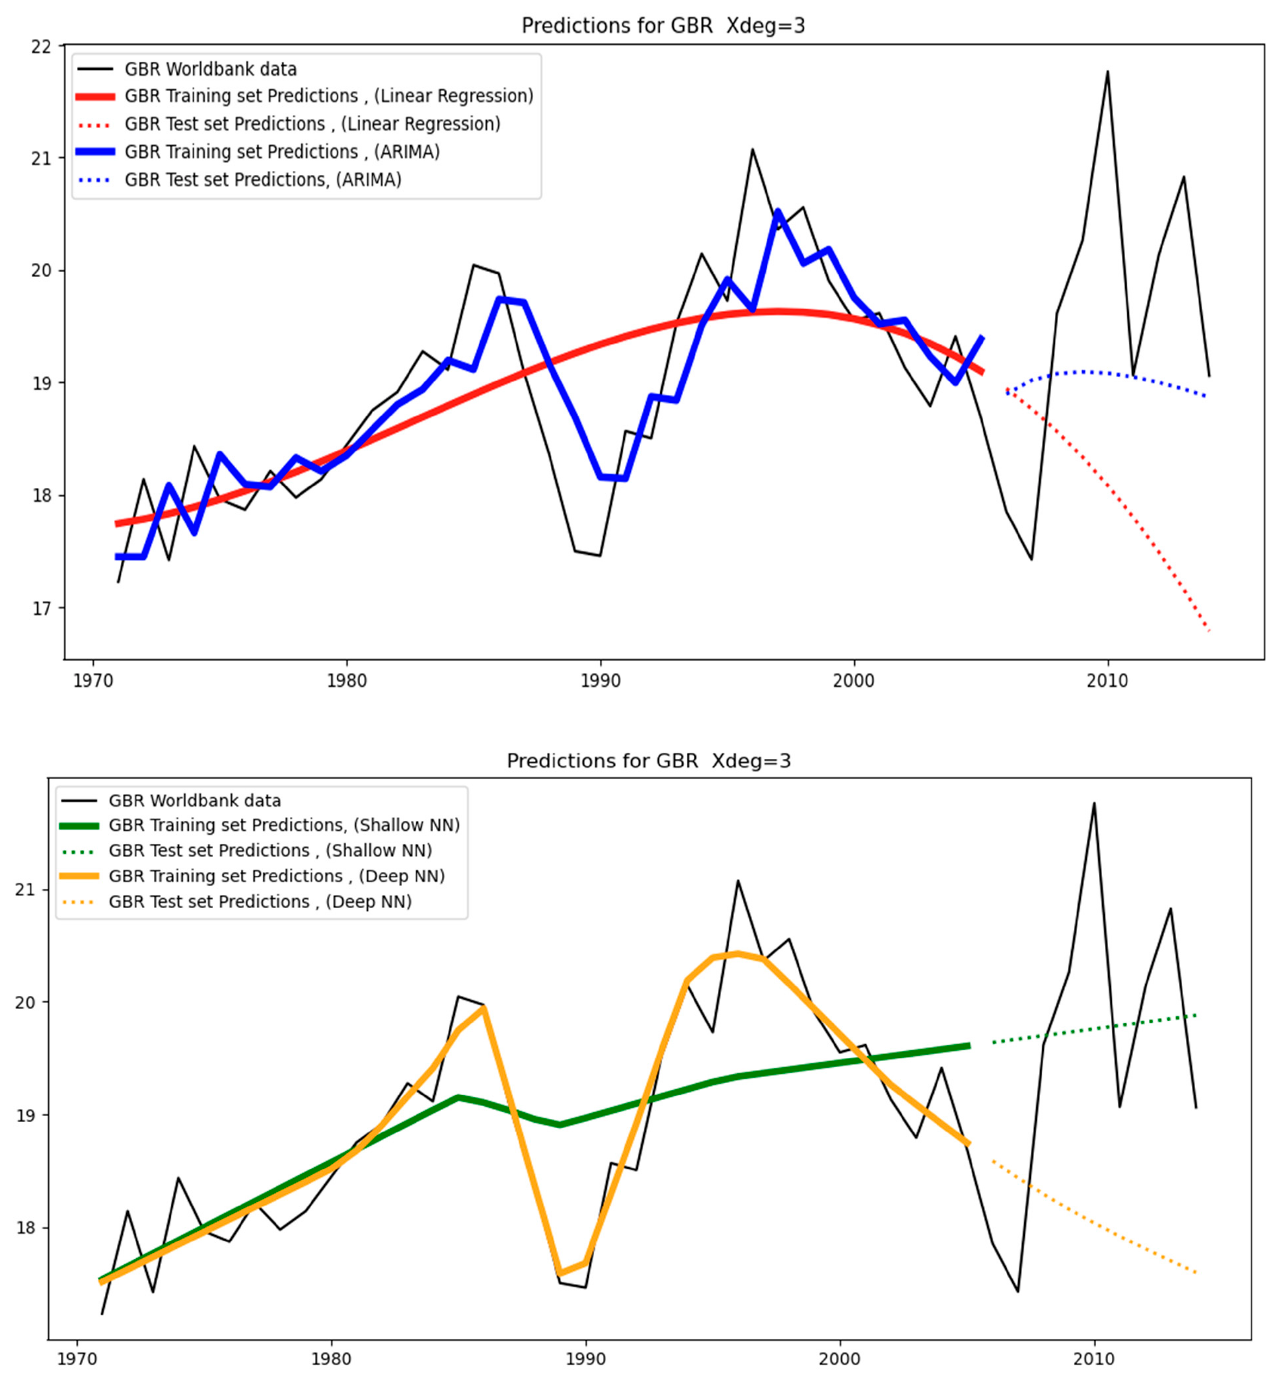
Figure 12. Predictions for Great Britain (GBR), with a third-degree polynomial (Xdeg = 3), are shown for both the training set (periods 1971–2005) and the test set (periods 2006–2014), using linear regression (LR), ARIMA, shallow neural networks, and deep neural network